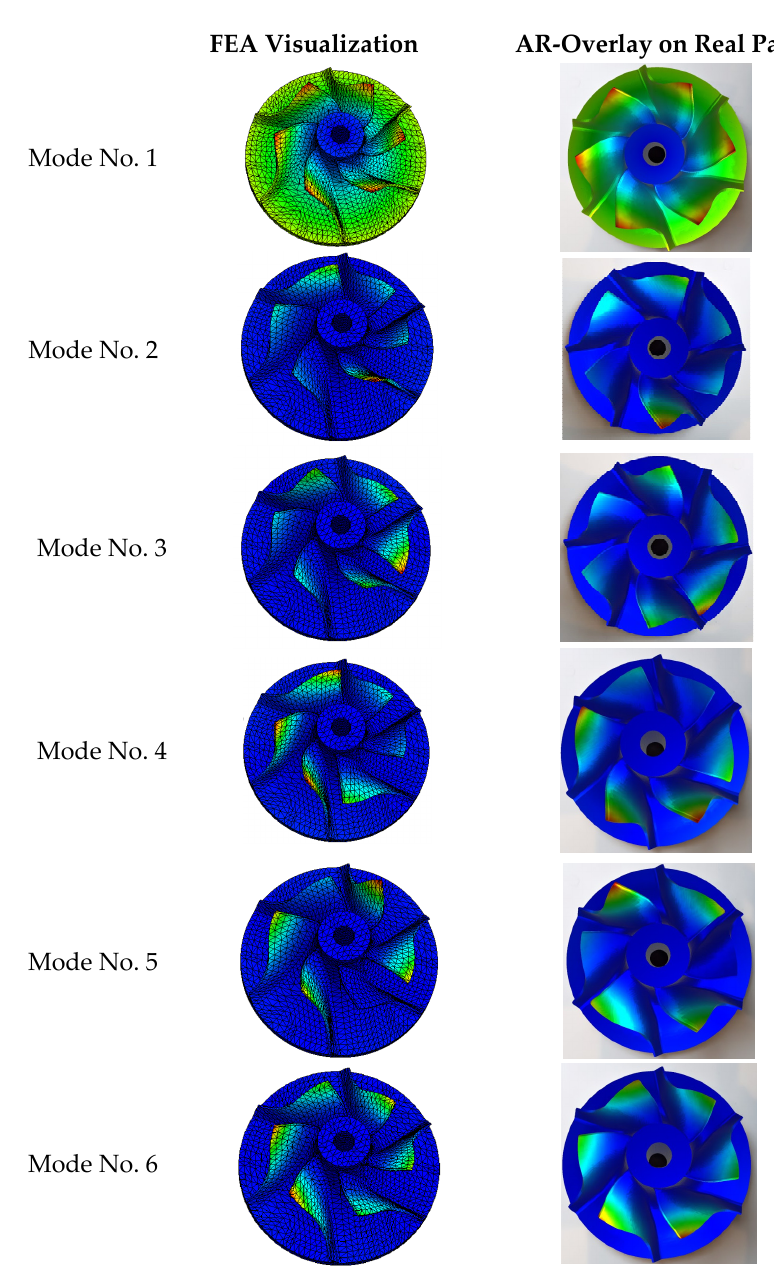
Figure 10. Modal analysis simulation results for modes 1 to 6 on the mobile AR visualization.